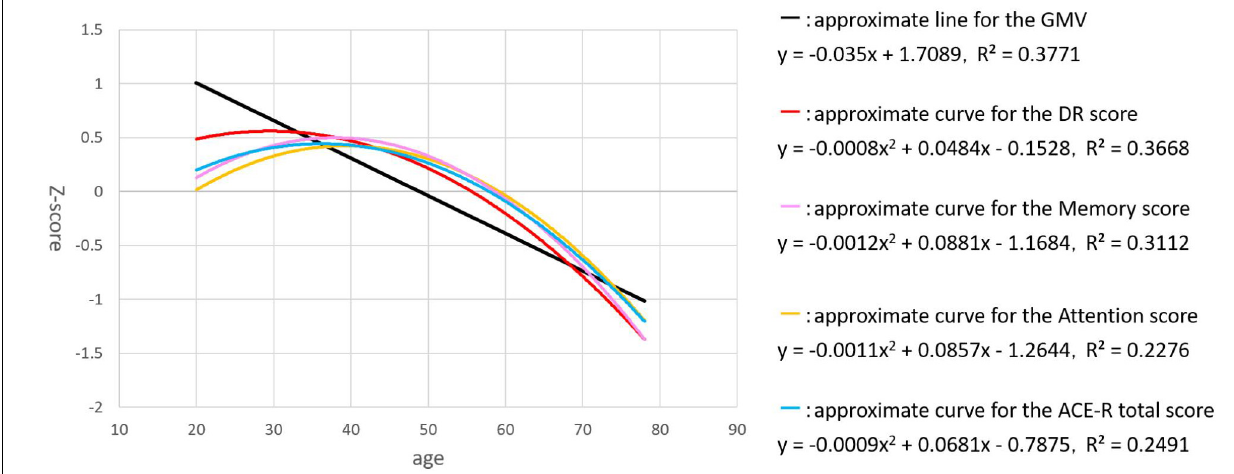
FIGURE 2 | The plots for GMV (black), the DR score (red), ACE-R total score (blue), attention / orientation (yellow), and memory (pink), as functions of age are shown. The vertical axis showed the volume and the score of each subject as a standardized z-score, and the horizontal axis is age.